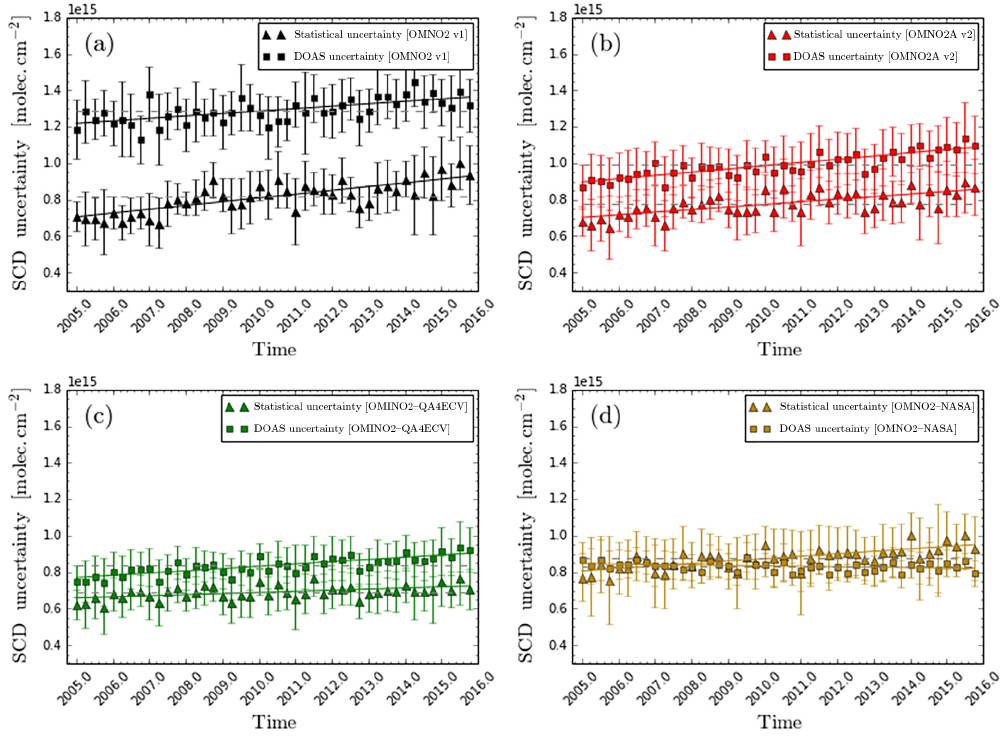
Figure 9. Temporal evolution of the statistical (triangles) and DOAS (squares) OMI NO 2 SCD uncertainty over 2005–2015 (Pacific orbit from day 1 of January, April, August, October) for OMNO2A v1 (black), OMNO2A v2 (red), OMINO2–QA4ECV (green), and OMNO2– NASA (yellow) algorithms. The solid line is the linear regression fitted to the data. The error bars represent 1 standard deviation (1 σ) . The slope, p , of each fit on the statistical, p s , and DOAS uncertainty, p d , is